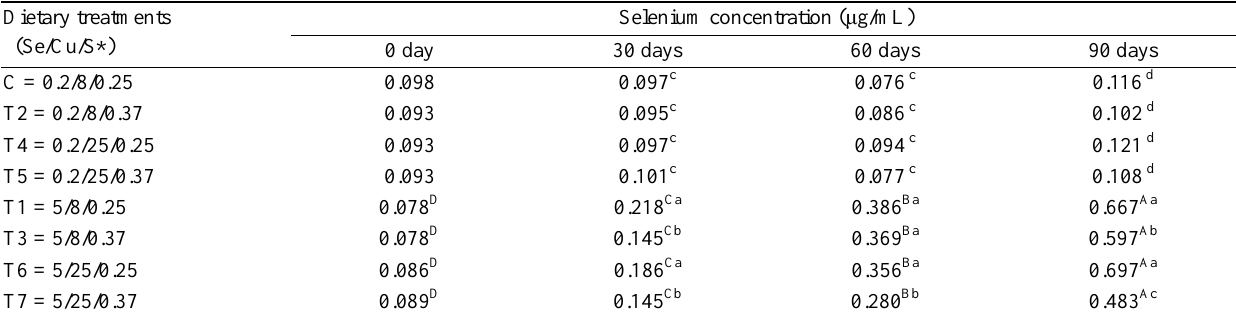
Table 2. Selenium concentration in blood serum of lambs receiving different concentrations of sulfur, selenium and copper in diet Dietary treatments